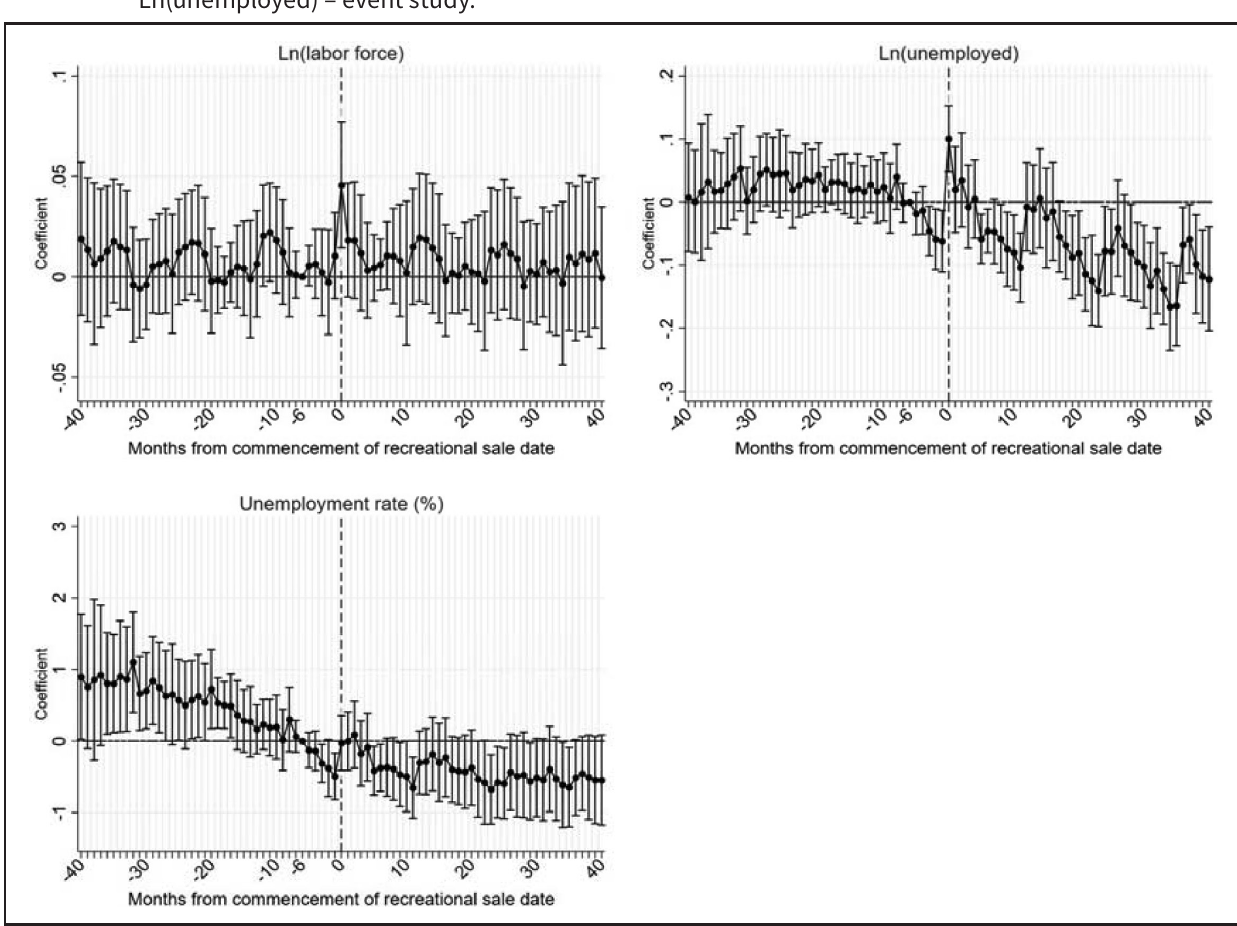
Effect of recreational cannabis entry on the unemployment rate, Ln(labor force), and Ln(unemployed) – event